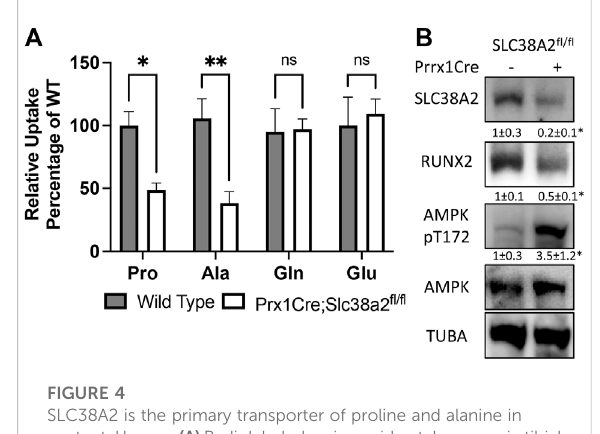
FIGURE 4 SLC38A2 is the primary transporter of proline and alanine in postnatalbones. (A) Radiolabeledaminoaciduptakeassaysintibial or humeral diaphyses isolated from 4-month-old wild type or Prrx1Cre;Slc38a2 fl / fl mice.* p < 0.05,** p < 0.005.N=9,8,7or 5 for Pro, Ala, Gln or Glu respectively. (B) Western blot analyses of femur extracts isolated from 4-month-old mice. SLC38A2